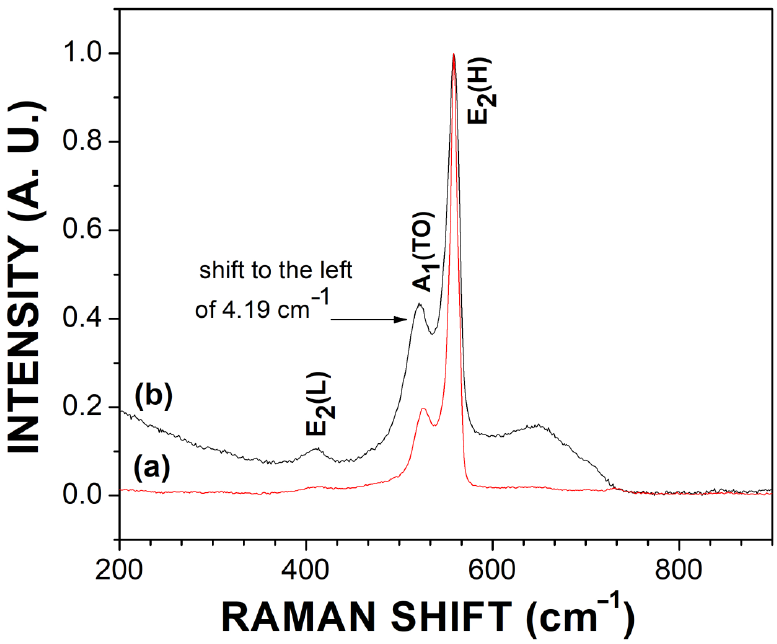
Figure 10. ( a ) Raman scattering of the undoped GaN powders; ( b ) Raman scattering of the Mg-Zn co-doped GaN powders. co-doped GaN